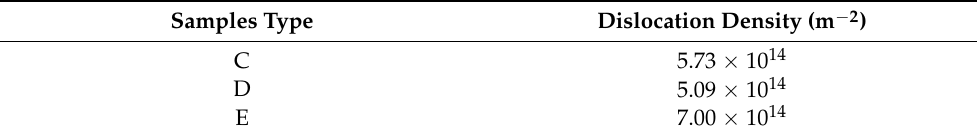
Table 3. The initial density of dislocations for different microstructures of DMLS Ti6Al4V(ELI) [21]. Samples